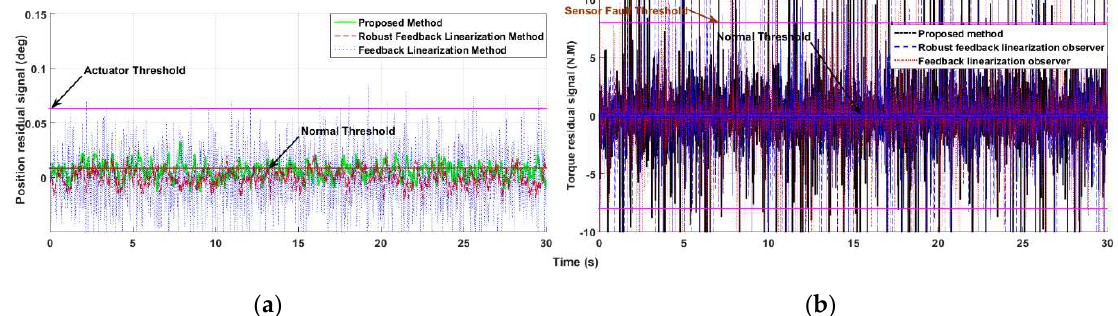
Figure 16. ( a ) Position residual signals and ( b ) torque residual signals for sensor fault identification based on the fuzzy ARX-Laguerre feedback linearization method, fuzzy ARX-Laguerre robust feedback linearization method, and fuzzy ARX-Laguerre T–S fuzzy robust feedback linearization method for the surgical robot for the sinus.